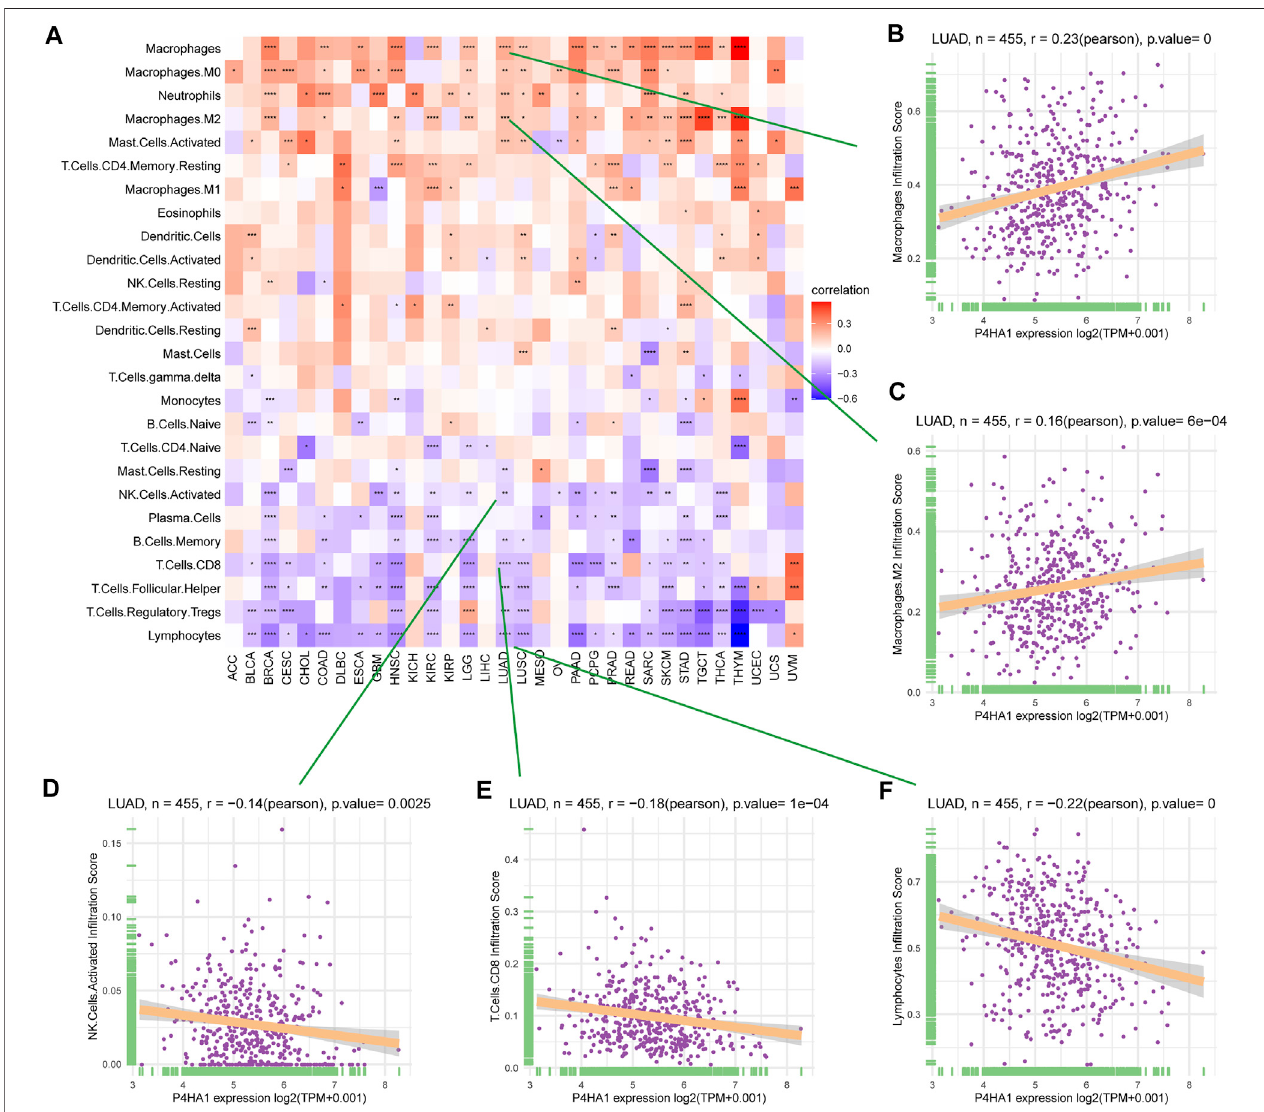
FIGURE8| Immunein fi ltrationanalysisbasedondatafrompublishedresearch. (A) TherelationshipbetweenP4HA1expressionandin fi ltrationlevelsof26immune cellsinpan-cancer. (B) ThecorrelationbetweenP4HA1expressionandin fi ltrationlevelsofTAMs. (C) ThecorrelationbetweenP4HA1expressionandin fi ltrationlevelsof M2-like TAMs. (D) The correlation between P4HA1 expression and in fi ltration levels of NK cells. (E) The correlation between P4HA1 expression and in fi ltration levels of CD8 T cells. (F) The correlation between P4HA1 expression and in fi ltration levels of lymphocytes. * p < 0.05, ** p < 0.01, *** p < 0.001, **** p < 0.0001.